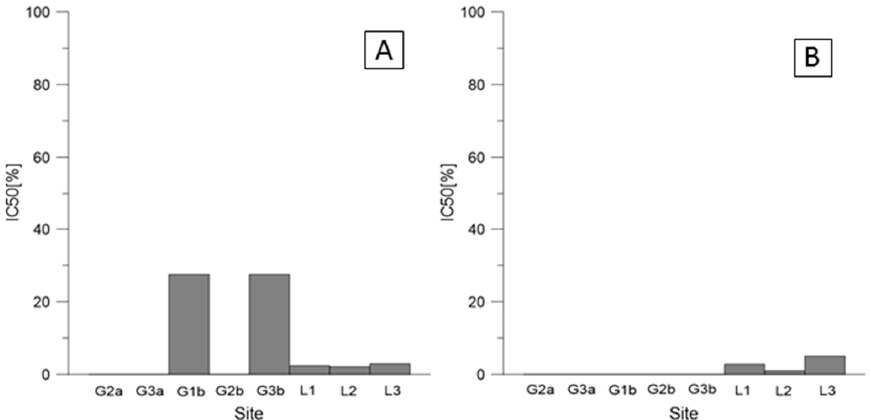
Table 1. The concentrations of heavy metals [mg·kg − 1 ] in the vicinity of four studied